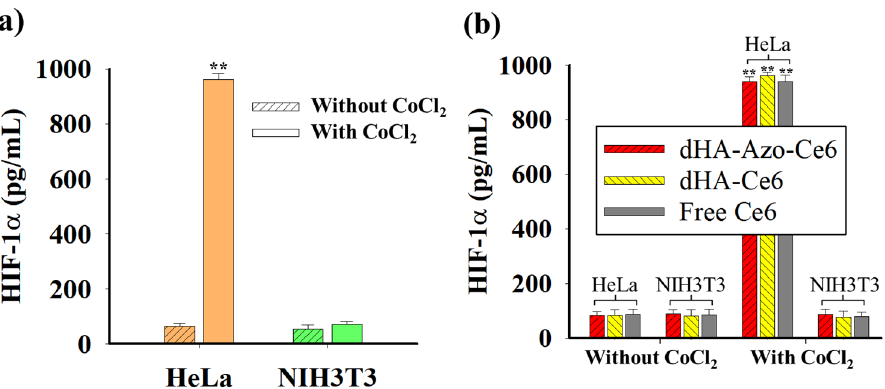
Figure 4. ( a ) HIF-1 α expression levels in cells (HeLa and NIH3T3) with or without CoCl 2 treatment (n = 3, as multiple experiments, ** p < 0.01 compared to HeLa cells without CoCl 2 ). ( b ) HIF-1 α expression levels in HeLa and NIH3T3 cells treated with each sample (10 μ g/mL equivalent of Ce6) or free Ce6 (10 μ g/mL) before and after CoCl 2 treatment (n = 7, as multiple experiments, ** p < 0.01 compared to HeLa or NIH3T3 cells without CoCl 2 ).